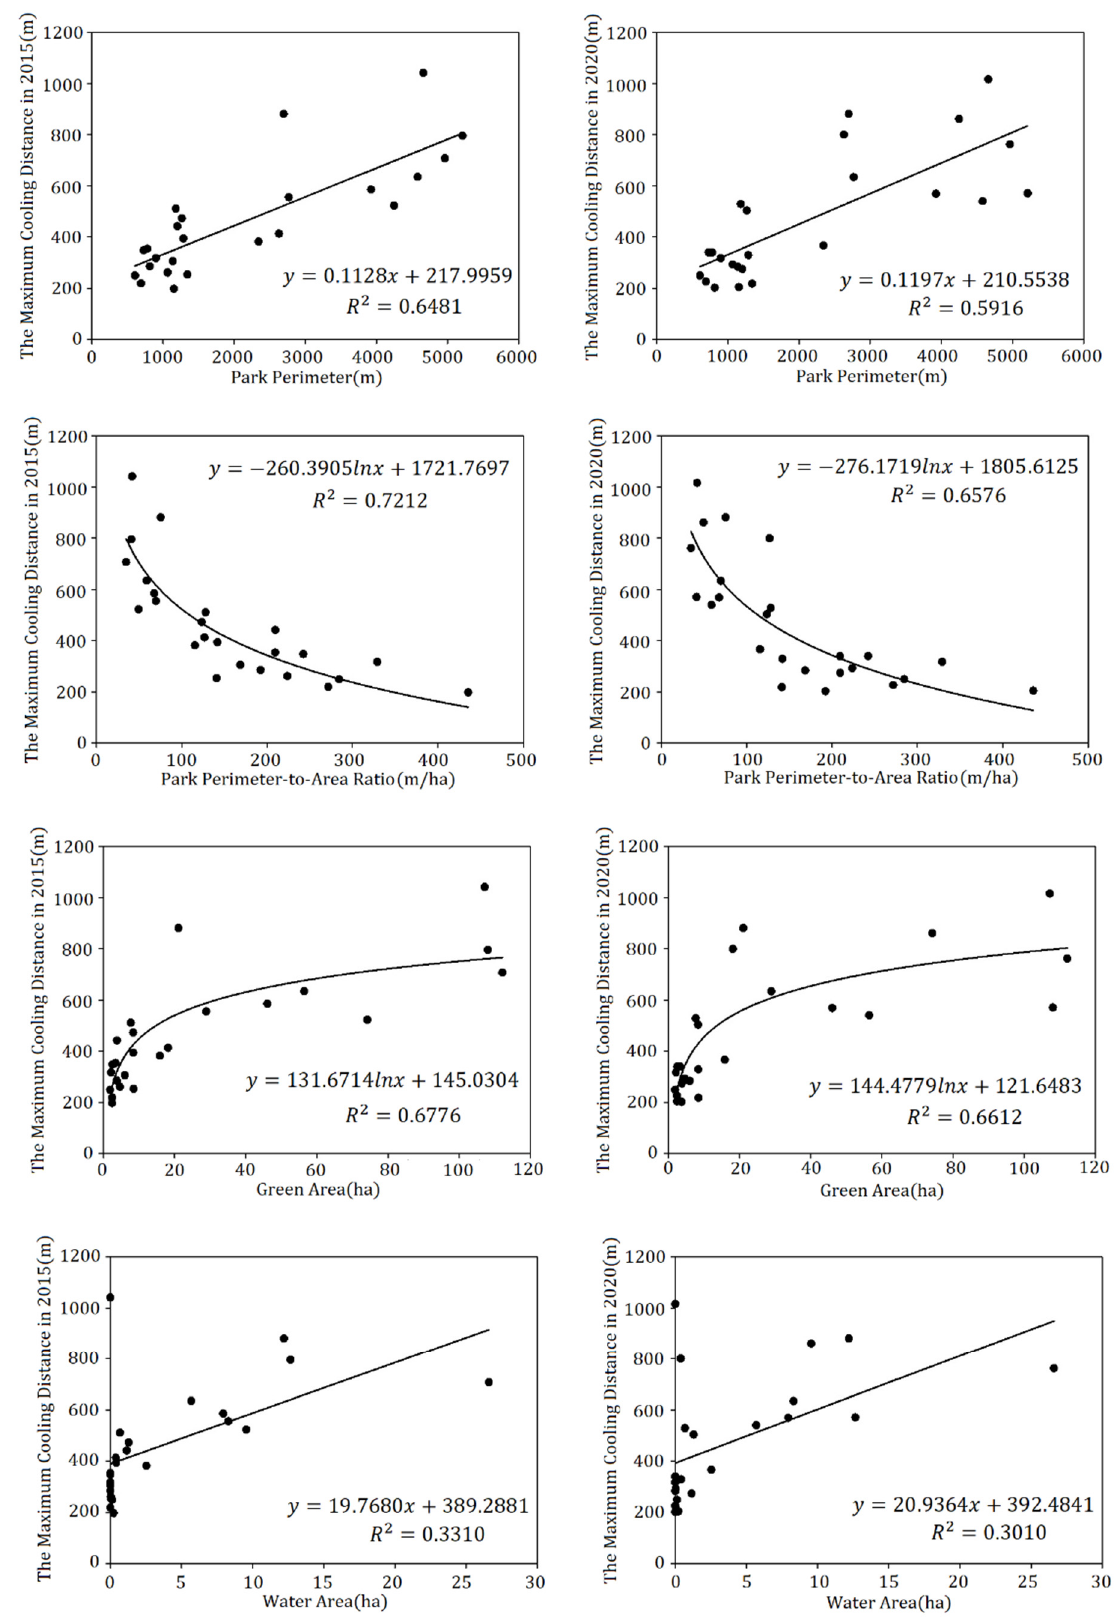
Figure 7. Correlation of park landscape metrics of PA, PP, PPAR, GA, WA with MCD for 2015 and 2020.